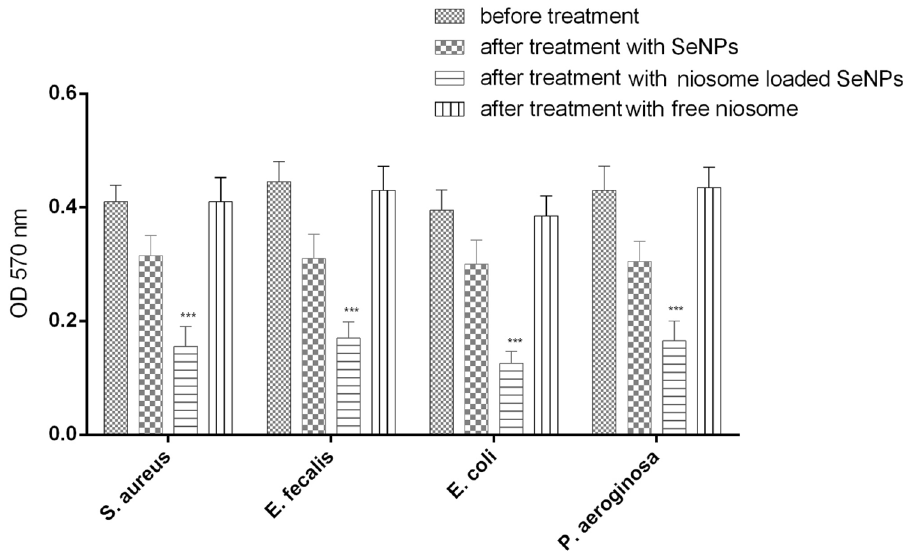
Figure 5. Anti-biofilm activity of free SeNPs, free niosome, and noisome-loaded SeNPs. Data represent the mean ± SD (n = 3). Error bars represent standard deviations. *** p <